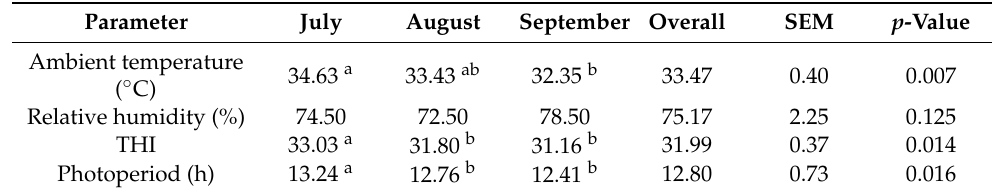
Table 2. Experimental ambient temperature, relative humidity, temperature–humidity index (THI), and photoperiod; data are presented as means ± standard errors of the mean (SEM).